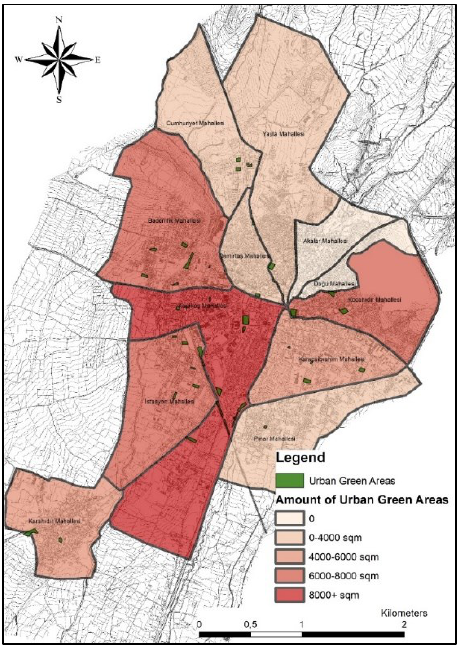
Figure 4. Amount of Urban Green Areas by